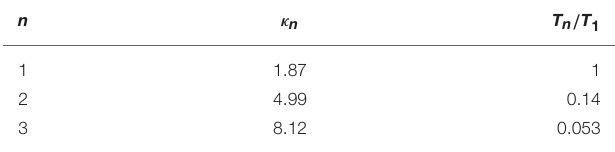
TABLE 1 | Constants κ n and T n / T 1 used in the expansion in Equation (8).